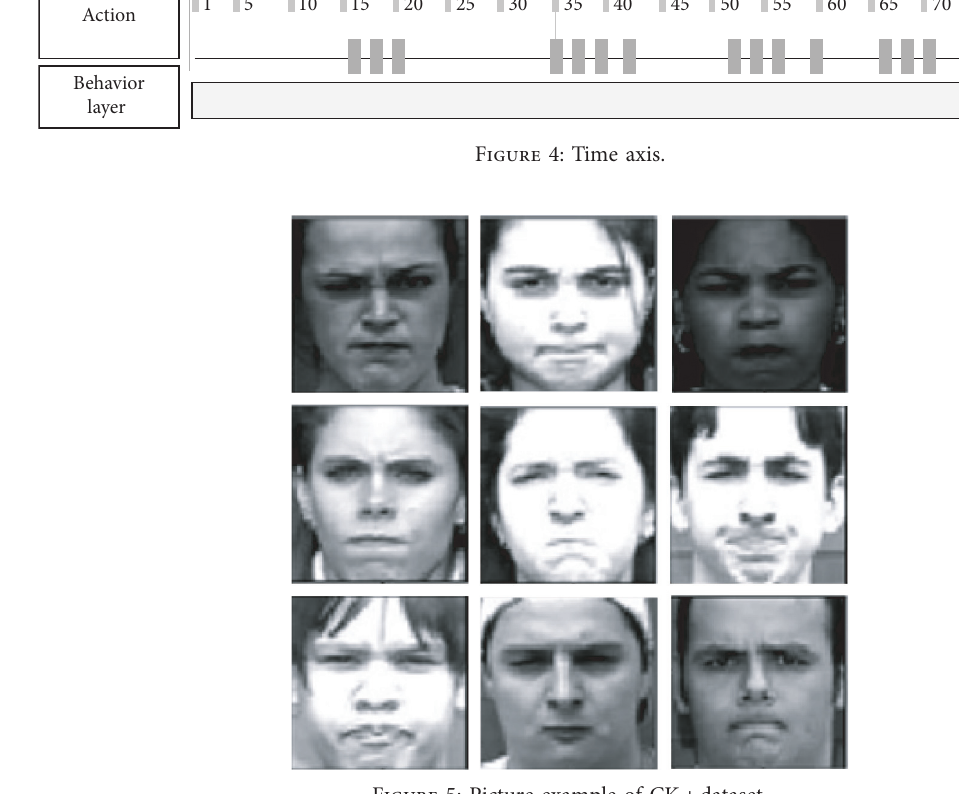
Figure 5: Picture example of CK+dataset.